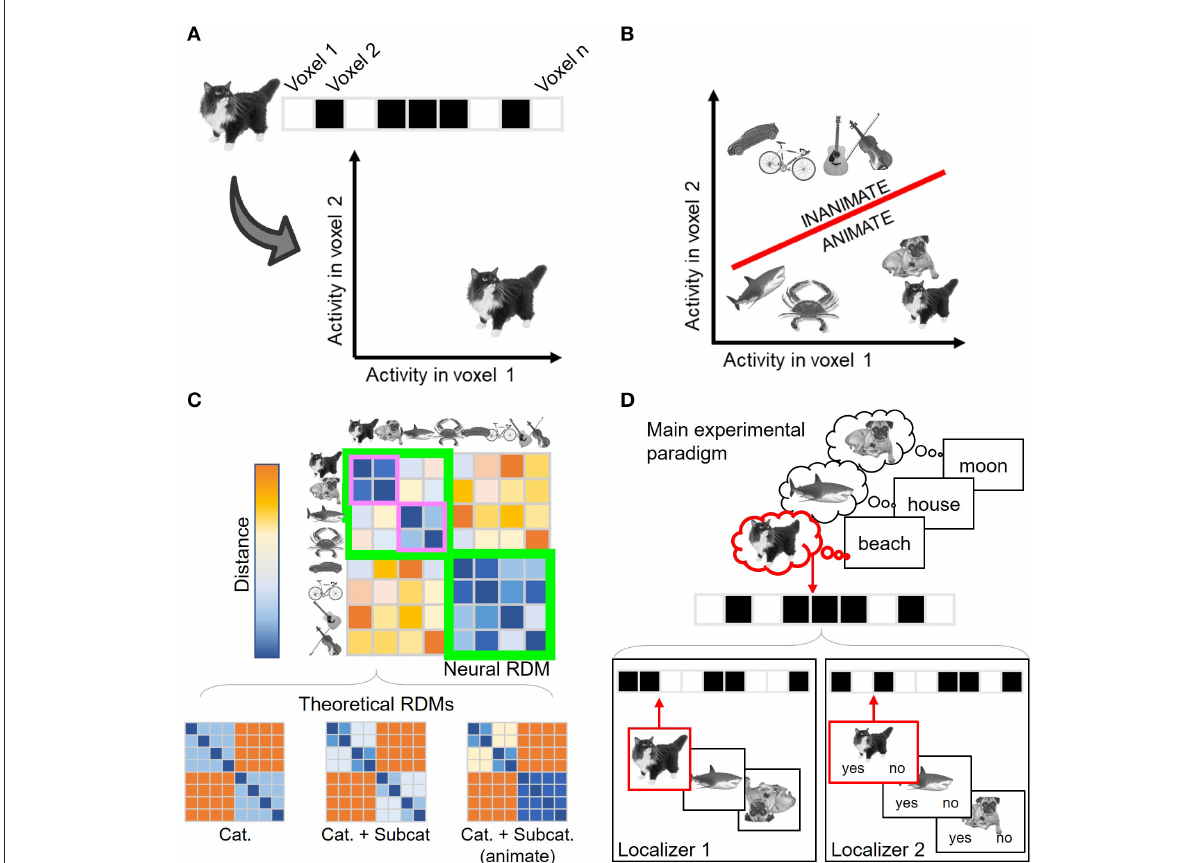
FIGURE1 Overview of the different multivariate analyses. (A) Neural representations can be understood as points in an n -dimensional space, where n corresponds to the number of spatial units considered. A two-dimensional (i.e., two voxels) space is shown here for visualization purposes. Each condition (in this example, each stimulus) is defined by its associated activation across the spatial units. (B) Decoding analysis seeks to assess how differentiable are the conditions’ representations in this space. To do so, a boundary (shown in red) that separates two (or more) conditions is first estimated and later tested with independent, unlabeled activity patterns. In this example, the boundary classifies between two category conditions: animate and inanimate stimuli. (C) Representational Similarity Analysis (RSA) describes the geometry of the space computing the similarity structure across conditions. In the example, the estimated similarity matrix shows that the representations are organized not only by the stimulus category (animate and inanimate stimuli, lower and upper quadrants shown in green) but also by the animate stimulus subcategory (mammals and non-mammal animals, shown in purple). RSA also enables characterizing the estimated encoding space using theoretical models. In this case, the third model (which predicts a broader animate/inanimate distinction together with further animate subcategory differentiation) will better predict brain data. (D) Canonical Template Tracking (CTT) estimates specific canonical neural representations using localizer tasks (lower panels) and then assesses their activation level during the main paradigm (upper panel). In the example, the paradigm is a memory retrieval task in which the participants retrieve the images that were associated with each word in a previous learning phase. The stimuli sensory templates (Localizer 1) are estimated with a task where upside-down images need to be detected, while semantic templates (Localizer 2) are estimated with a task in which the stimuli are categorized as mammals or non-mammals. Those templates are then compared against the activity patterns associated with the items retrieved during the main paradigm. Critically, the activation strength from the retrieved image template (in the example, the cat, shown in red) can be compared against the non-retrieved ones (e.g., the dog templates), which can act as baseline condition. Cat., Category; Subcat., Subcategory. Stimulus images were retrieved from the stimulus database employed in González-García et al. (2021), CCBY